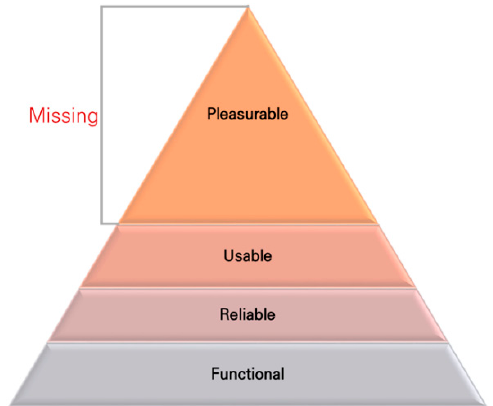
Figure 1. Hierarchy of human